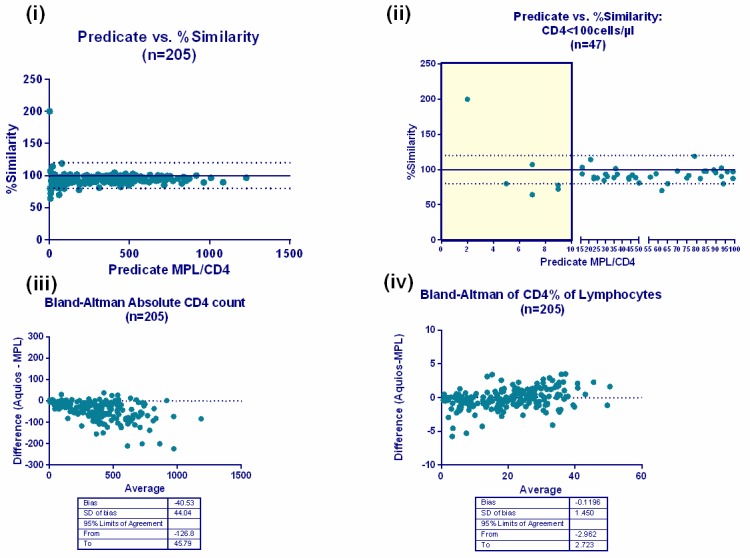
%Similarity and Bland-Altman analyses.(i) The % similarity (of Aquios vs. Predicate) plotted against the predicate absolute CD4 count indicating the distribution around the acceptable limits between 90–110%. (ii) A sub-analysis of CD4<100cells/μl of %Similarity vs. predicate absolute CD4 count reveals the greatest variability seen in samples with a numeric value <10 (shaded area). One marked outlier (arrow) reveals matching comparative counts of 2 cells/μl (predicate) vs. 4 cells/μl (Aquios). This example is used to provide evidence for the need to correct counts that are less than 50 cells/ μl to 100% similar and to avoid falsely biasing %Sim analysis outcomes. Below lie the Bland-Altman analyses (n = 205) comparing CD4 test platforms for (iii) absolute CD4 counts and (iv) CD4% of lymphocytes. Differences are expressed as Aquios (test) value minus MPL (predicate) value in the Bland Altman analyses.